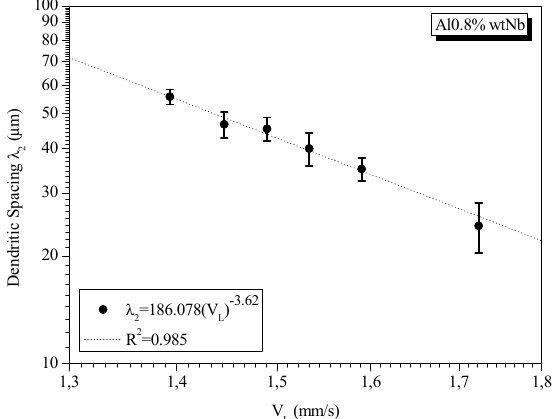
Figure 12. Experimental equation of the secondary dendritic spacing as a function of liquidus isotherm velocity for Al–0.8 Nb (wt.%).